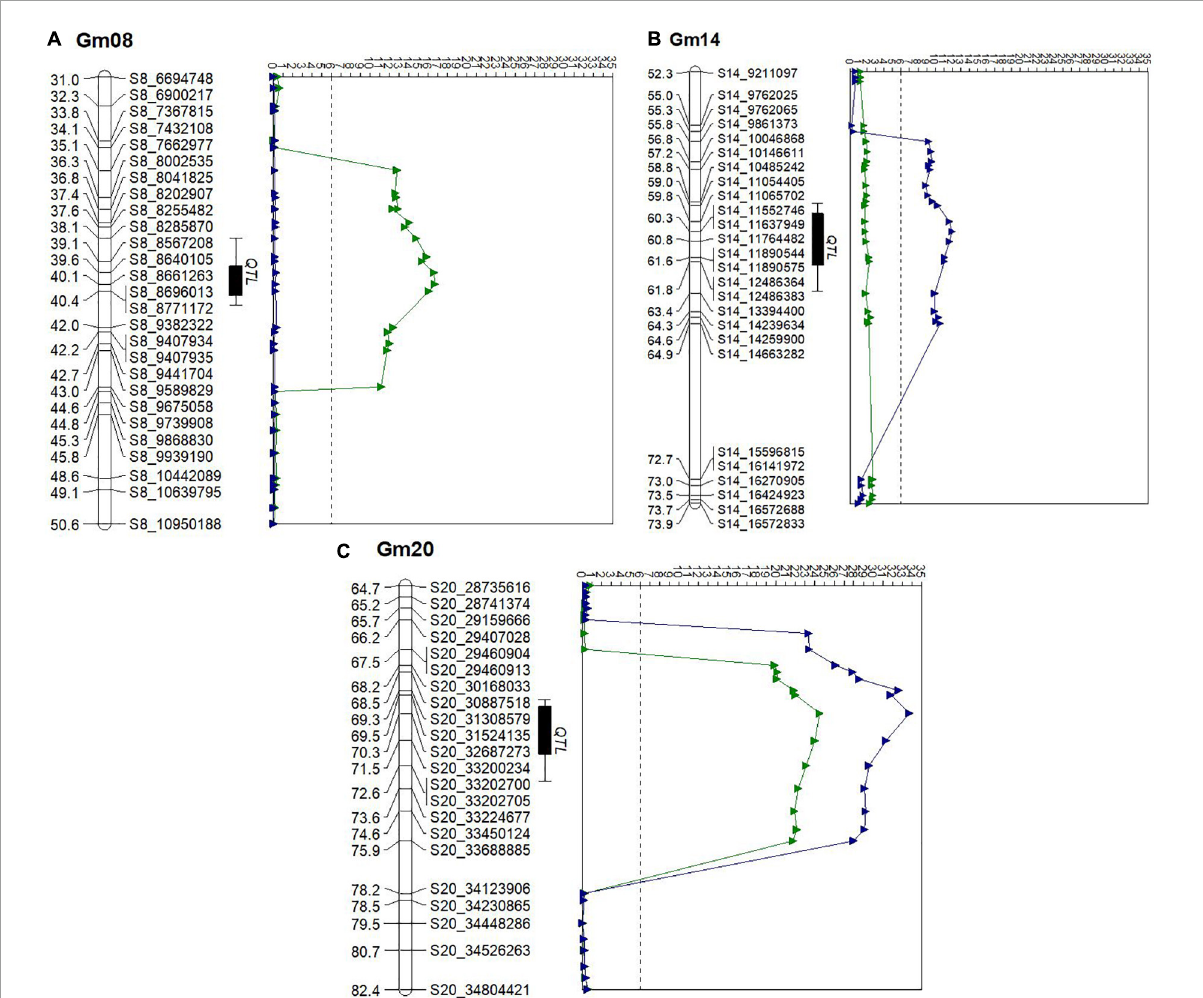
FIGURE1 Quantitative trait loci (QTL) LOD score traces for seed oil (green) and protein (blue) content in a population of Osage × PI593983 across four environments during 2016 and 2017 in Missouri. The vertical axis indicates the genetic map position along the chromosome. The horizontal axis represents the logarithm of the odds (LOD) score. The black dotted line indicates the threshold of significance (LOD = 6.0). (A) Chr8. (B) Chr14. (C)